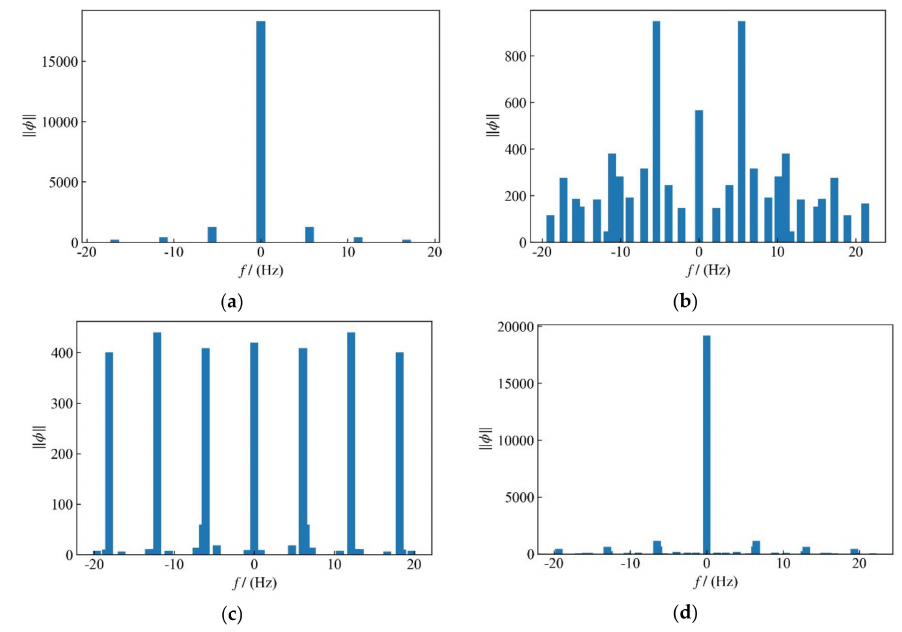
Figure 10. Energy distribution of (Dynamic Mode Decomposition) DMD modes at di ff erent spacing ratios: ( a ) L / D = 2; ( b ) L / D = 2.5; ( c ) L / D = 3; ( d ) L / D = 4.